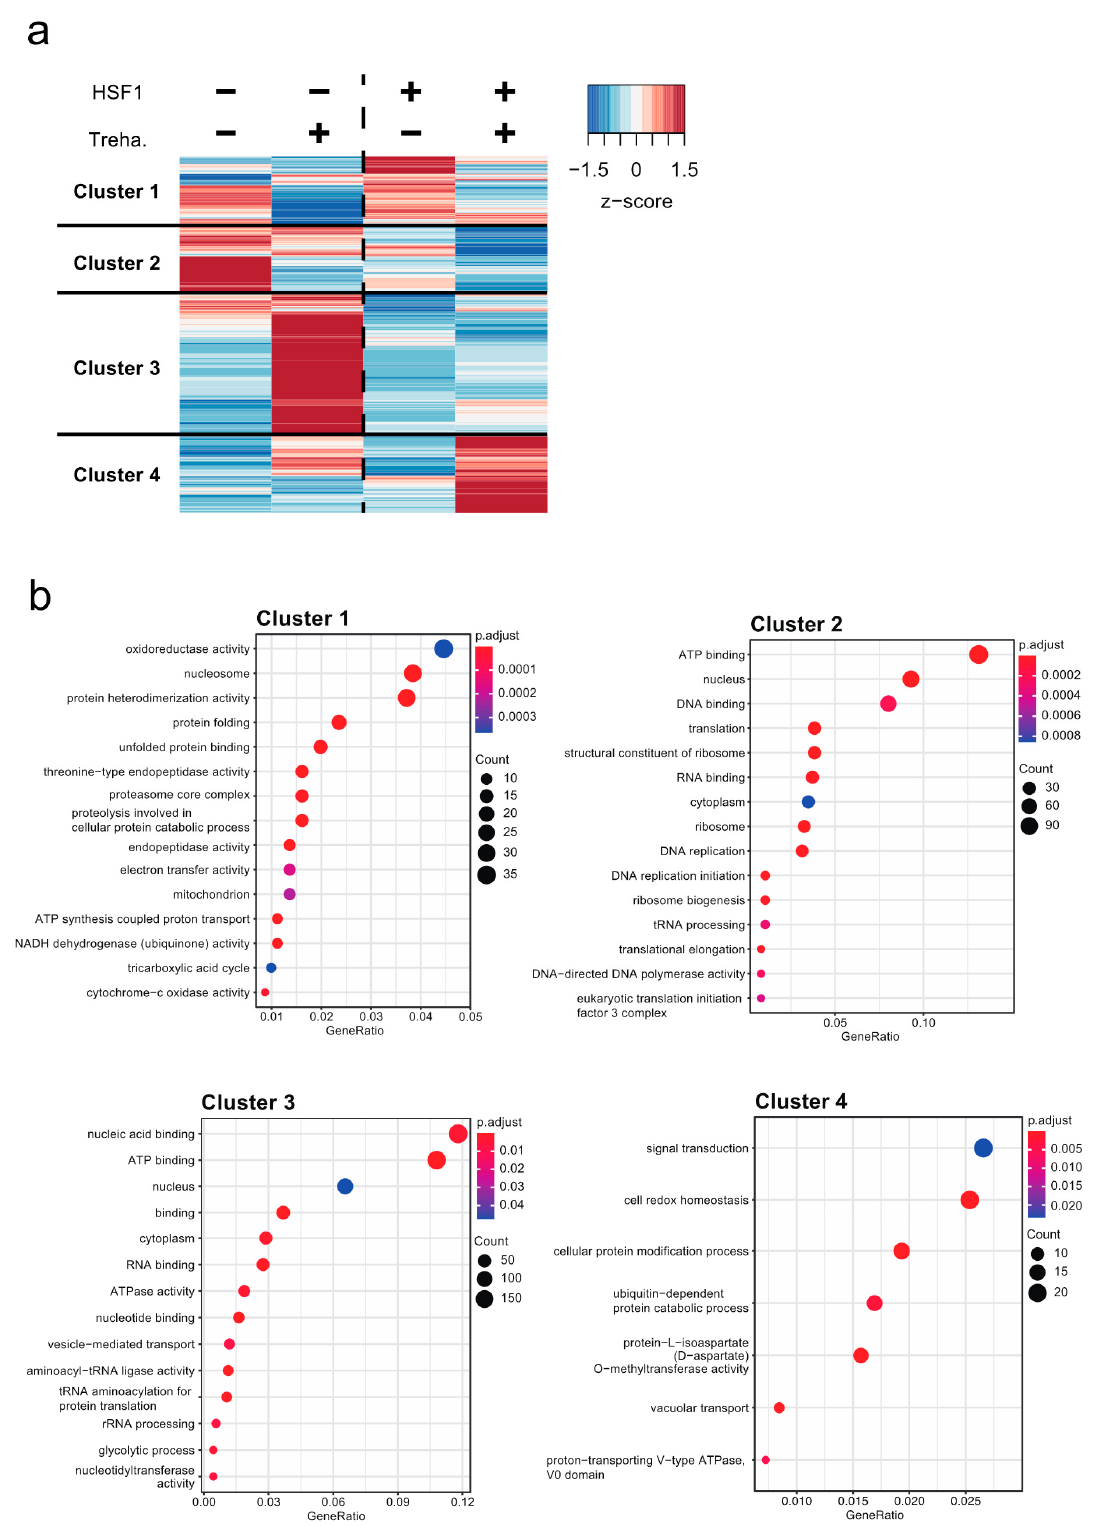
Figure 3. Transcriptome changes in Pv11 cells following HSF1-knockout and -rescue: ( a ) Hierarchical clustering based on TPM of Hsf1 − / − ; HaloTag/BlaR and Hsf1 − / − ; Hsf1 -HaloTag/BlaR cell lines during trehalose treatment. Red and blue color indicates high expression level and low expression level, respectively. The horizontal and vertical axes show sample and the number of differentially expressed genes (DEGs), respectively. HSF1 − , Hsf1 − / − ; HaloTag/BlaR; HSF1+, Hsf1 − / − ; Hsf1 -HaloTag/BlaR; Treha. − , before trehalose treatment (T0); Treha. +, after trehalose treatment (T48); ( b ) GO enrichment analysis for each cluster in ( a ). All genes with or without GO annotation are listed in Data